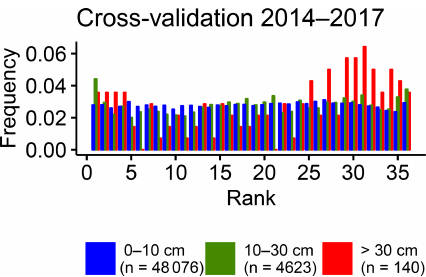
Figure 9. Cross-validated rank histograms of the post-processed HN forecasts from local-scale calibration with the real-time fore- casts dataset. The evaluation is done separately for winters 2014, 2015, and 2016 with the training period 2014–2018 excluding the evaluation year. The three HN classes are the same as in Fig. 3b.